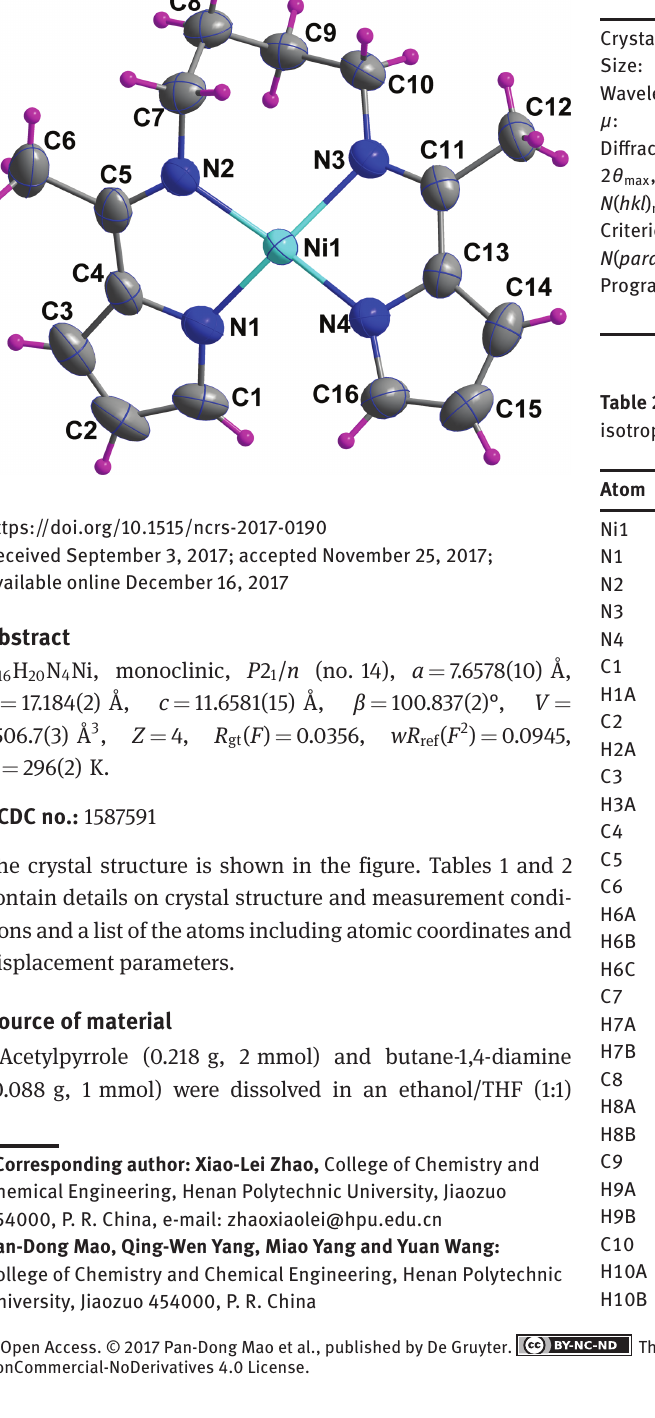
Table 1: Data collection and handling.